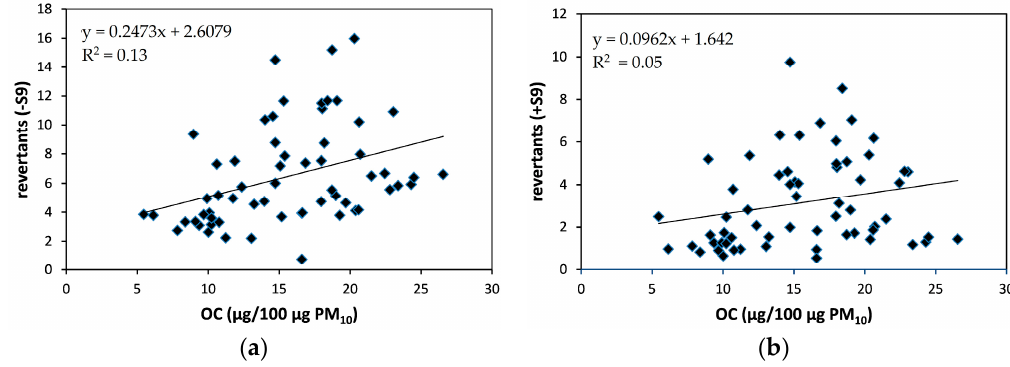
Figure 7. Scatterplots of OC with direct ( a ) and indirect mutagenicity ( b ). Direct and indirect mutagenicity are expressed as the number of revertants/100 µg PM 10 -equivalent.